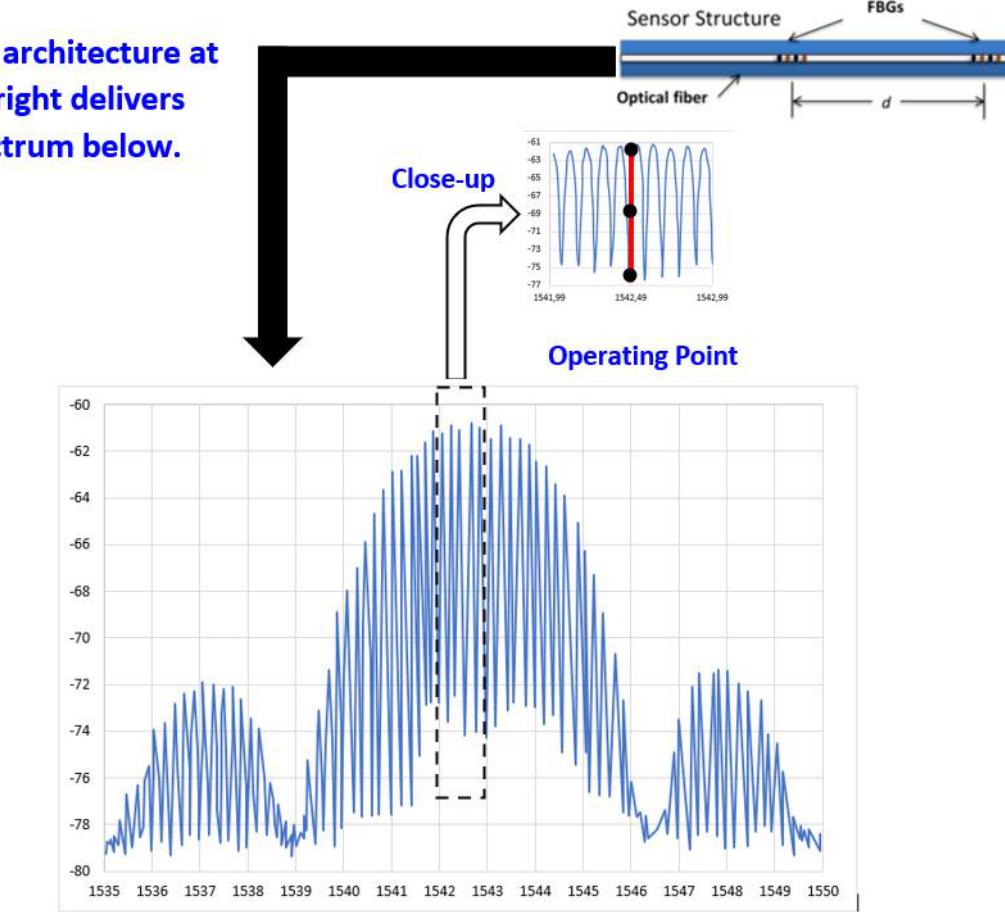
Figure 3. Reflection Spectrum for a fiber optic vibration sensor.